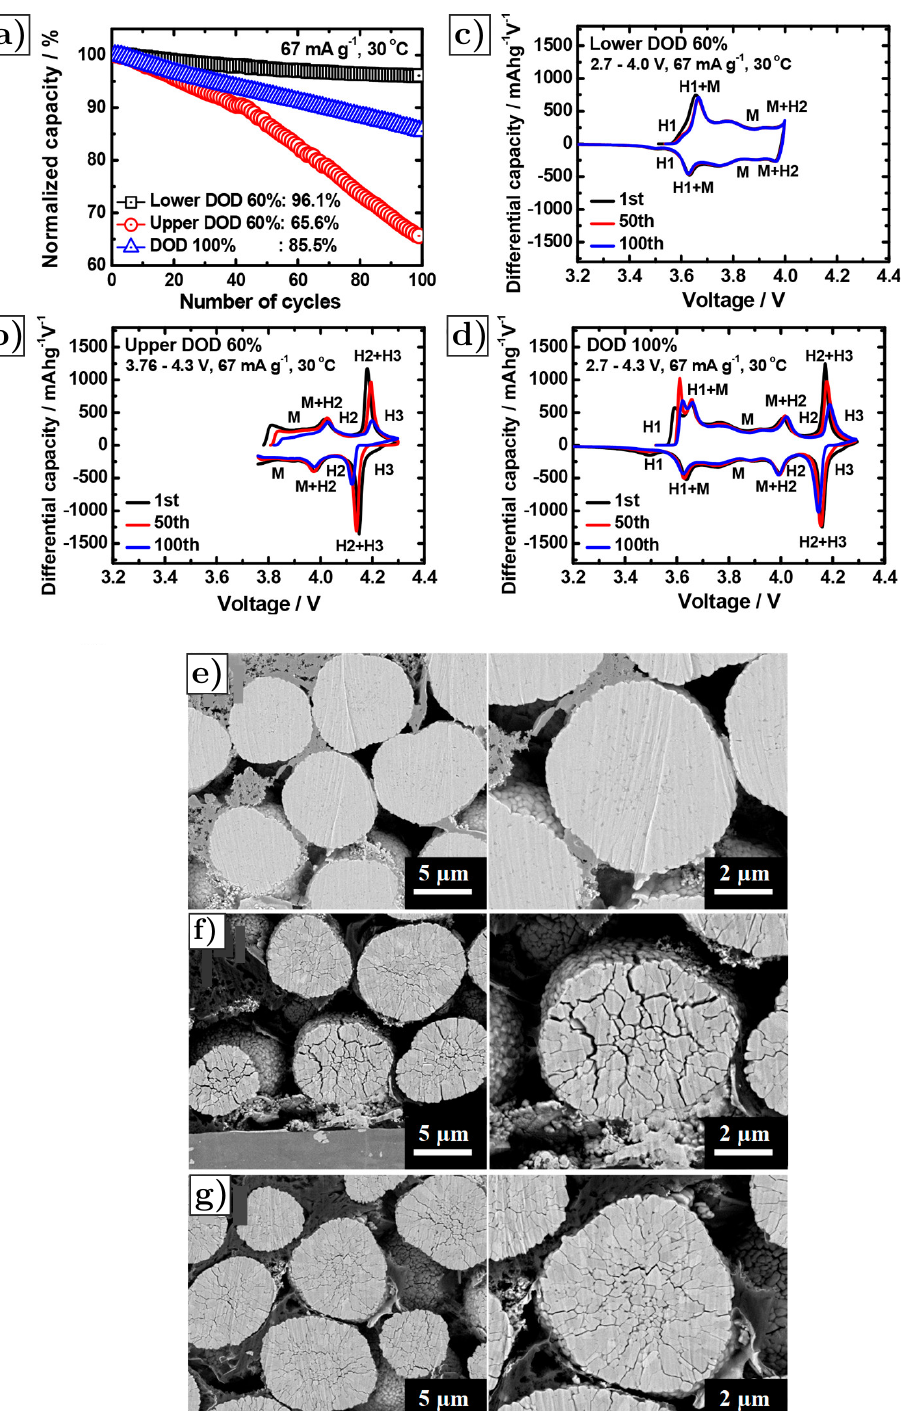
Figure 27. ( a ) Capacity decay of NCA95 during cycling at different DOD and initial SOC values. Derivative of charge-discharge curves of NCA95 cycled ( b ) from SOC 40 to 100% (3.76–4.3 V) ( c ) from SOC 0 to 60%, ( d ) from SOC 0 to 100%. Cross-sectional SEM images of NCA95 particles cycled for 100 cycles ( e ) from SOC 0 to 60%, ( f ) from SOC 40 to 100% and ( g ) from SOC 0 to 100%. Reprinted with permission by American Chemical Society from [132], Copyright